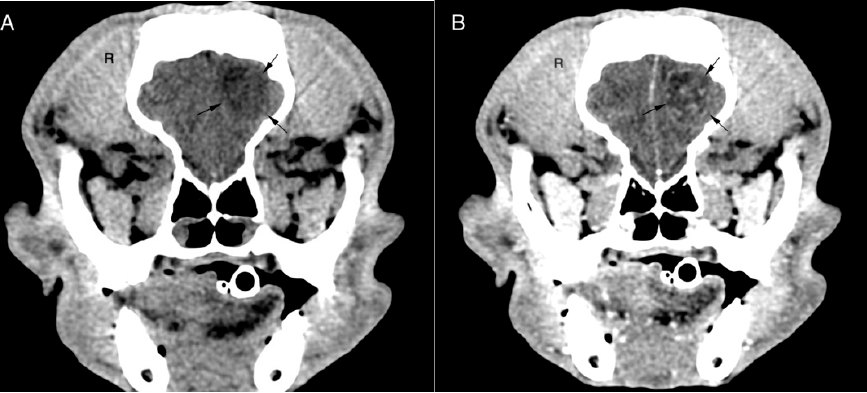
Figure 1. Transverse pre ( A ) and post ( B ) contrast CT brain image with soft tissue algorithm. The images reveal an intra-axial, ill-defined round, hypoattenuating lesion located in the left frontal lobe of the cerebrum. The lesion shows ring enhancement after ionated contrast administration and a slight midline shift to the right. Histopathological diagnosis was oligodendroglioma grade II. All dogs (14/14) were treated perioperatively with prednisone 0.5 mg/kg twice daily (Prednisone Alonga ® , Famar Health Care, Madrid, Spain) and, when seizures were present (n = 13/14), with additional antiepileptics drugs such as phenobarbital 3–6 mg/kg twice daily (Luminal ® , Kern Pharma, Barcelona, Spain) or/and levetiracetam 20–40 mg/kg three times a day (Keppra ® , UCB Pharma SA, Brussels, Belgium). Maropitant 1 mg/kg IV (Cerenia ® 10 mg/mL Zoetis, Madrid, Spain) was used preoperatively to prevent perianaes- thetic vomiting. During the surgery, all dogs received mannitol 0.5 g/kg IV